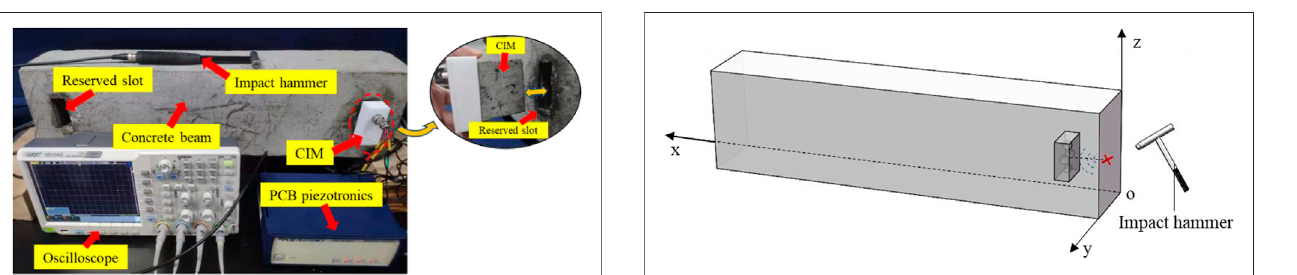
FIGURE 9 | Experimental setup.